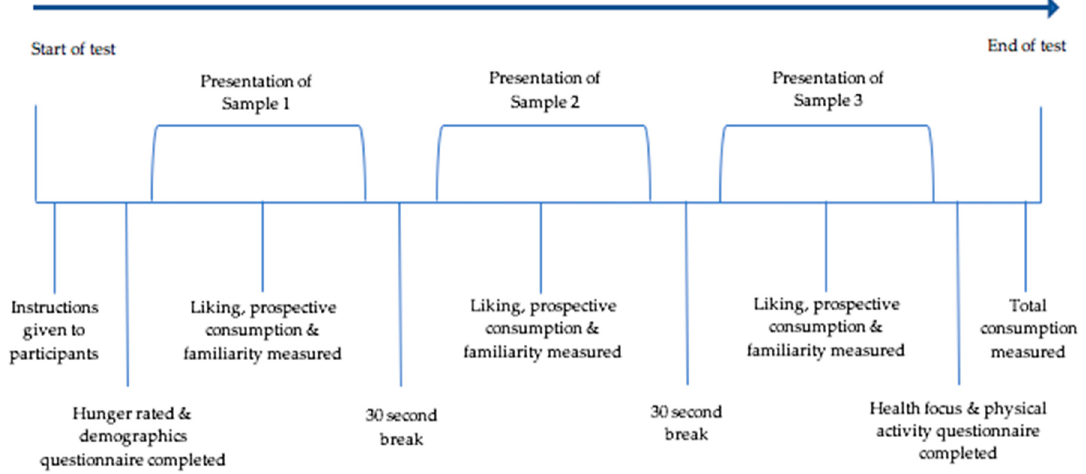
Figure 2. The procedure of a testing session.